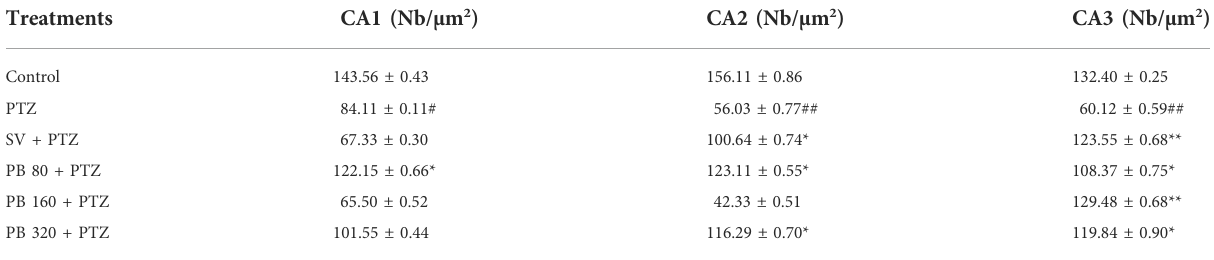
TABLE 3 The aqueous extract of P. biglobosa reduced degenerated/necrotic neurons in the hippocampus. Treatments